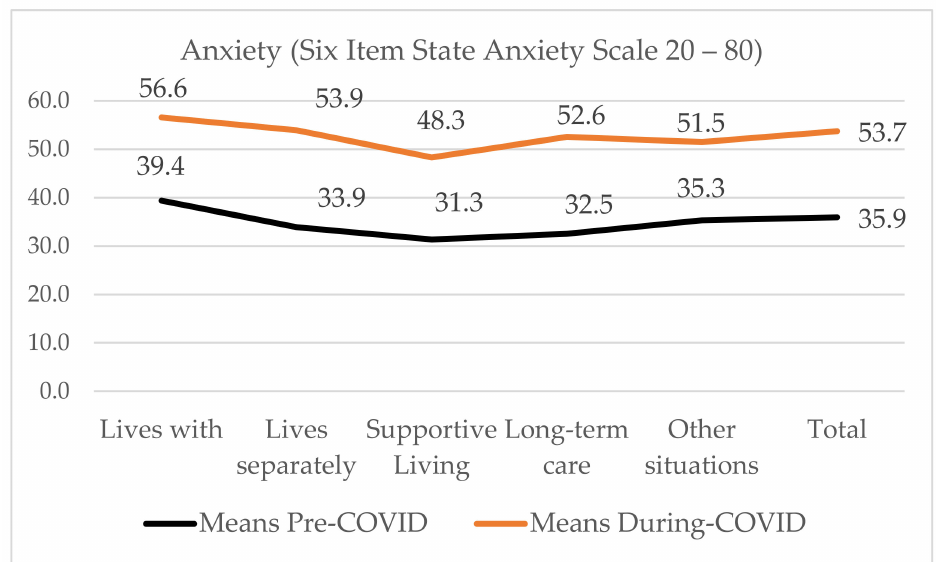
Figure 5. Mean anxiety by receiver’s residence.